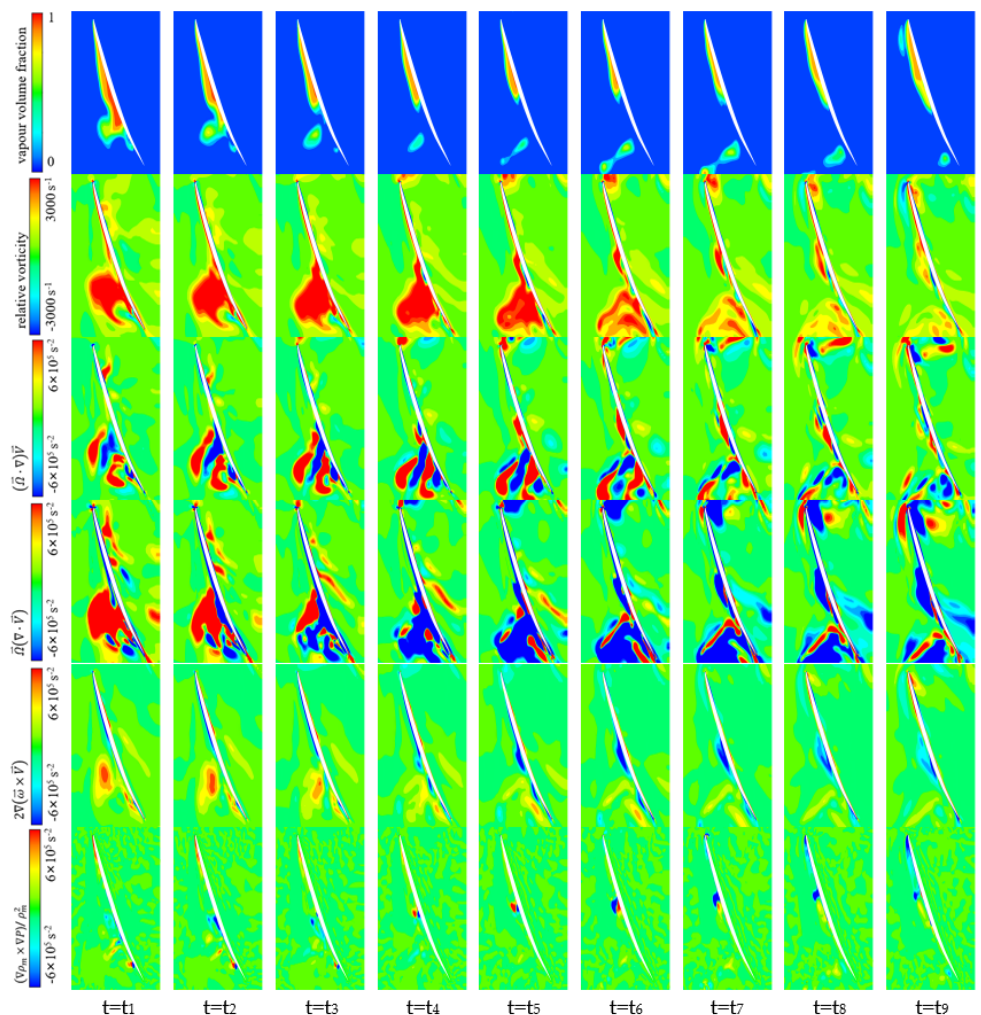
Figure 15. Various cloud diagrams of vapor volume fraction and vorticity transport equations for different span sections.